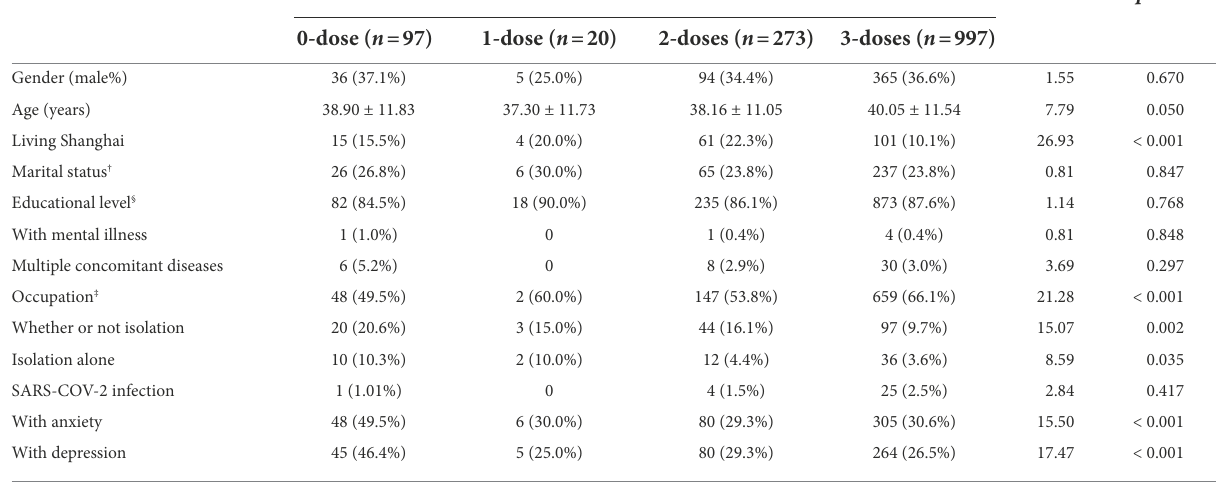
TABLE 2 The influence of the number of inactivated vaccine doses received on anxiety and depression.